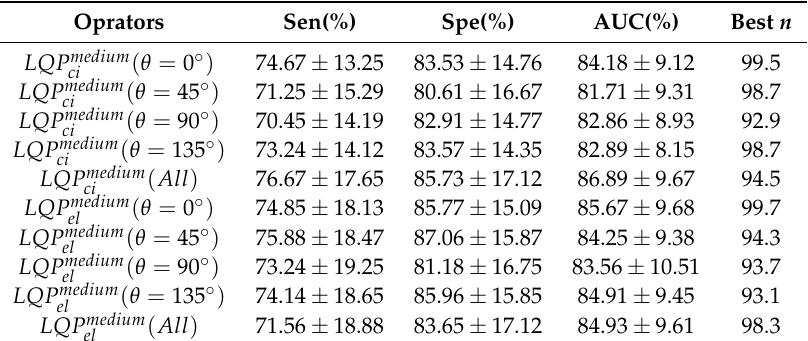
Table 5. Overall quantitative results for InBreast [15] database using circle and ellipse topologies. The parameters R and P are based on the values in Table